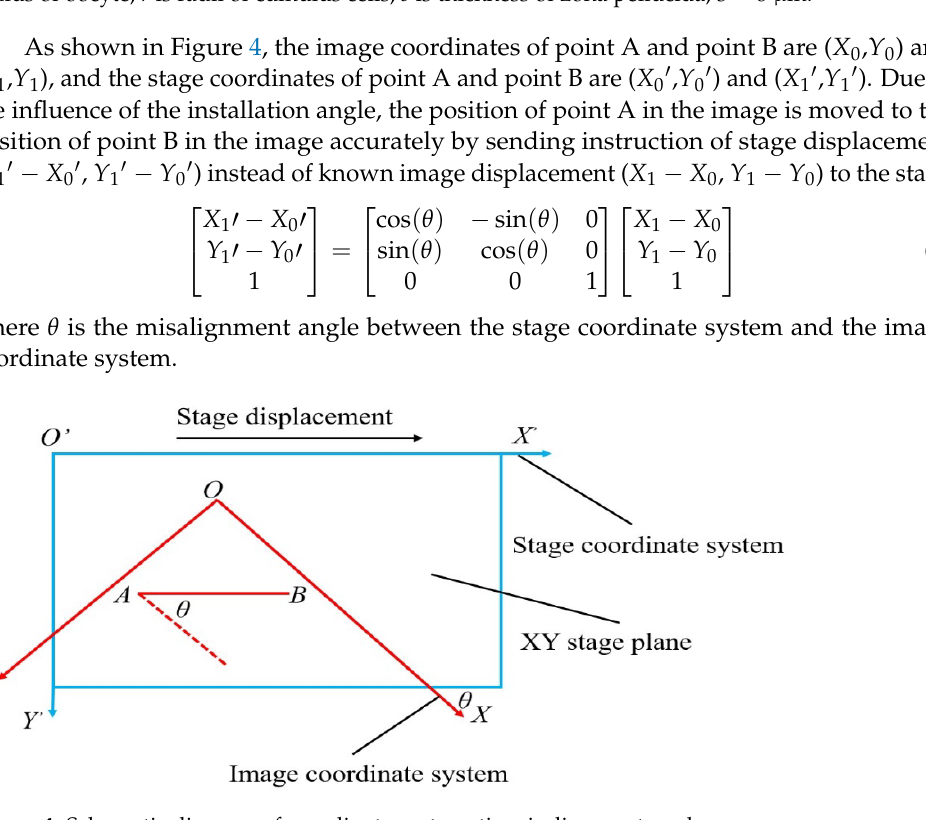
Figure 4. Schematic diagram of coordinate systematic misalignment angle.